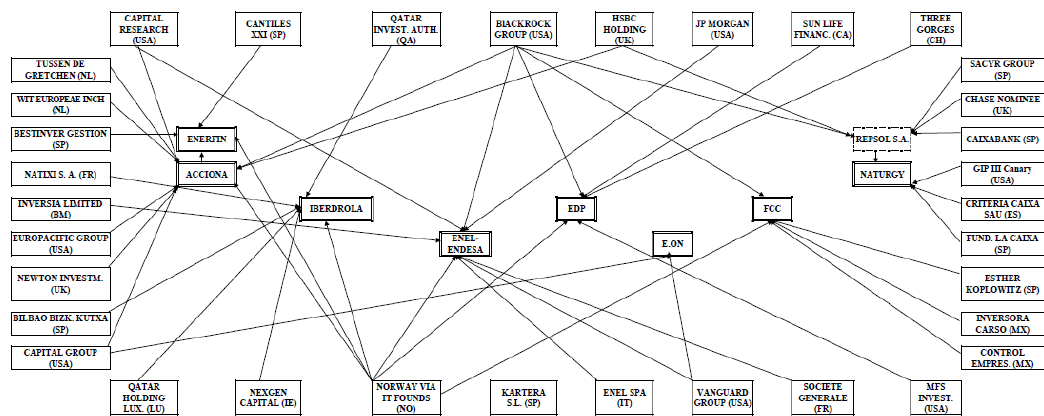
Figure 6. Network of the dominant owners of wind power companies in Galicia (1995 – 2017) elaborated from Table 5.